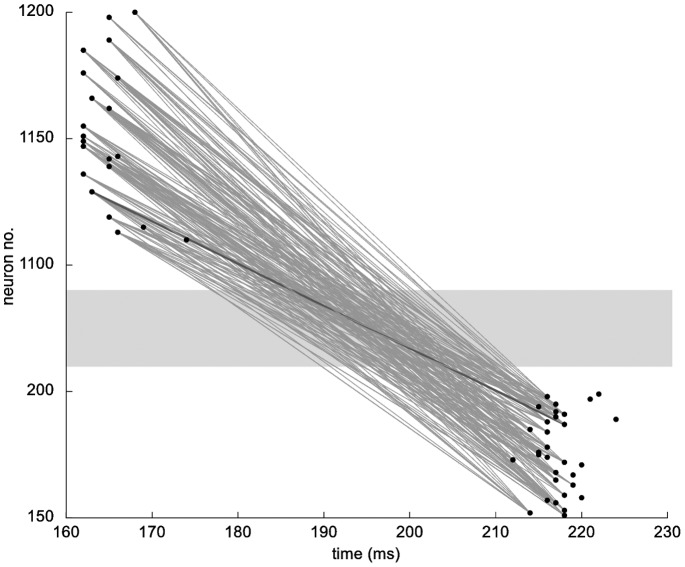
Neurons in the target pattern are driven by three different mechanisms.Thick lines mark connections, where one hippocampal output neuron can generate a spike in a cortical neuron. Thin lines indicate that these connections alone cannot generate a spike. Instead timed activity of more than one hippocampal neuron is needed to elicit a spike in the cortical neuron. Unconnected dots represent cortical neurons whose spiking is not directly evoked by the hippocampus, but by recurrent cortical inputs. Already in the learning process, autoassociative connections between the cortical neurons in target pattern emerge.